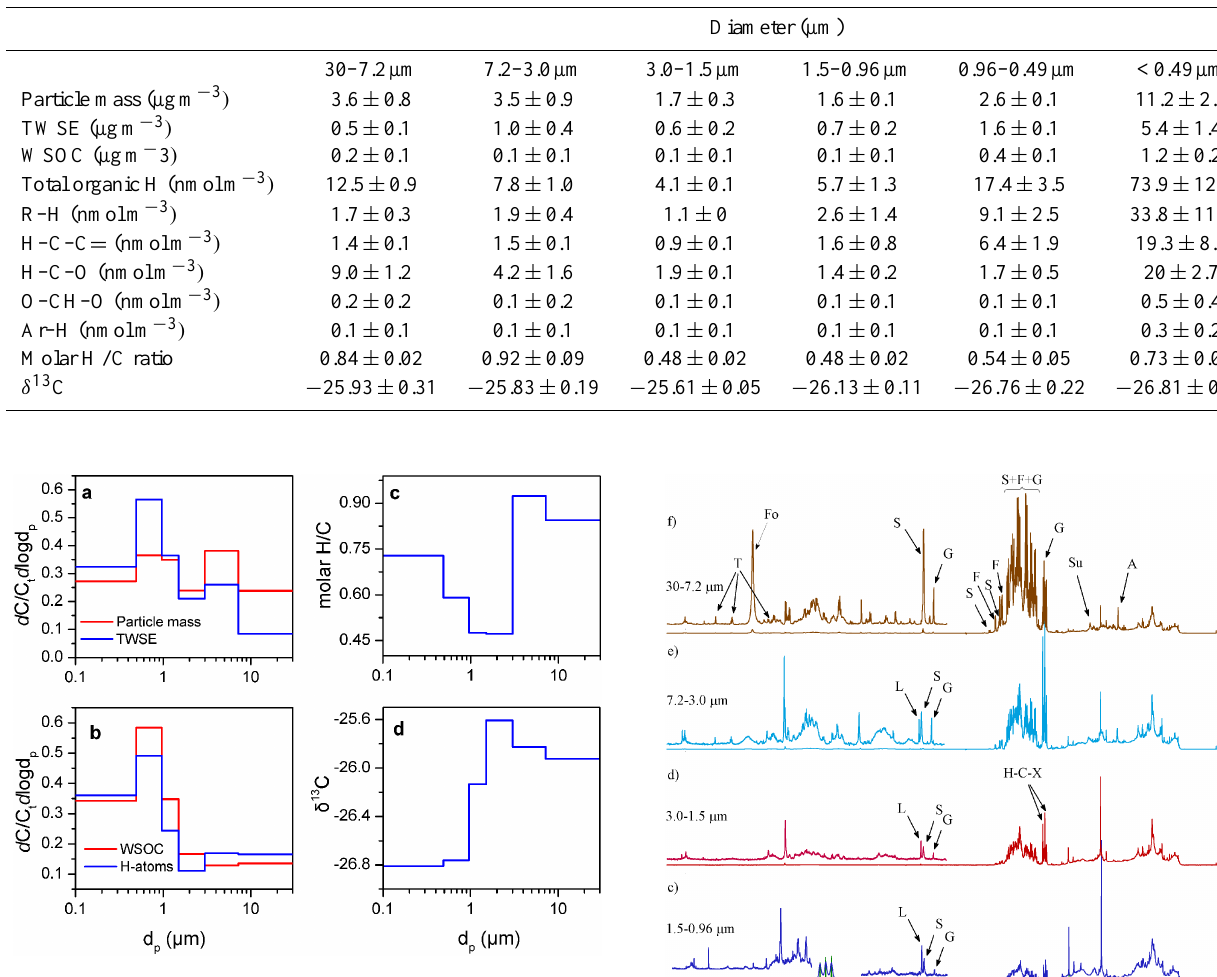
Figure 1. Size distribution for urban particle mass and TWSE (a) , WSOC and non-exchangeable organic hydrogen (b) , molar H/C ratio (c) and δ 13 C (d) . Table 3. Mass median aerodynamic diameter (in µm) of particle mass, TWSE, WSOC and non-exchangeable organic hydrogen.